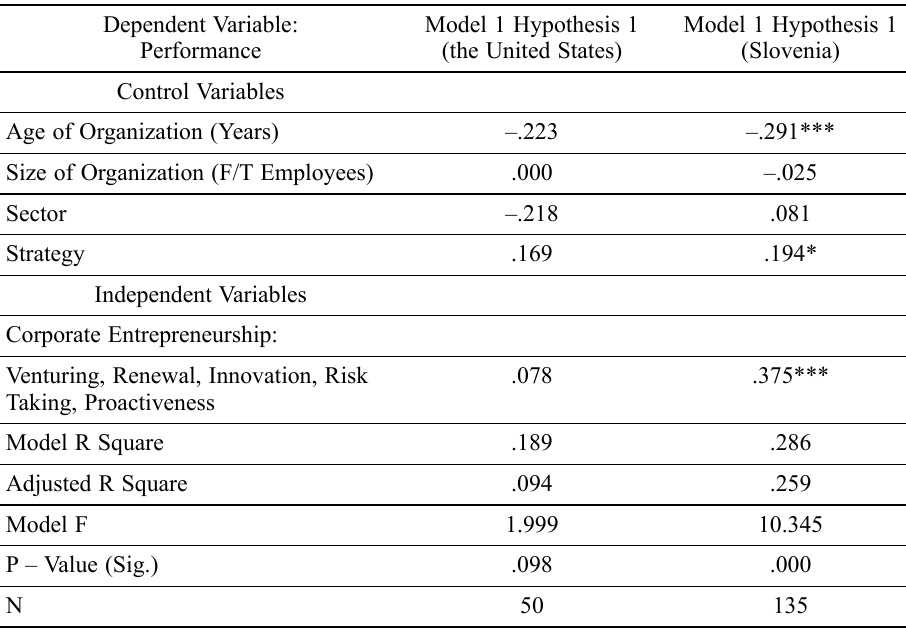
Table 5. Regression analysis results (private sector)